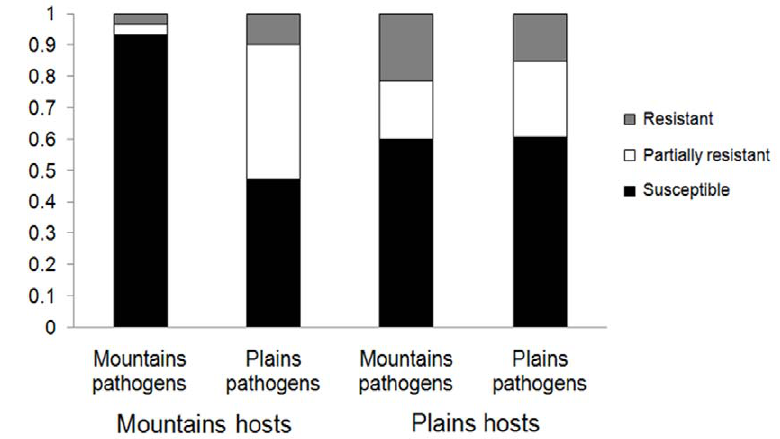
Figure 3. Regional adaptation of Plains and Mountains pathogens to their allopatric and sympatric hosts. Mean patterns of resistance in 5 Mountains and 5 Plains populations of L. marginale (30 plants per population) to 6 Mountains and 5 Plains isolates of M. lini. Infection type responses shown by hosts were classified into fully resistant, partially resistant or fully susceptible (see Materials & Methods).